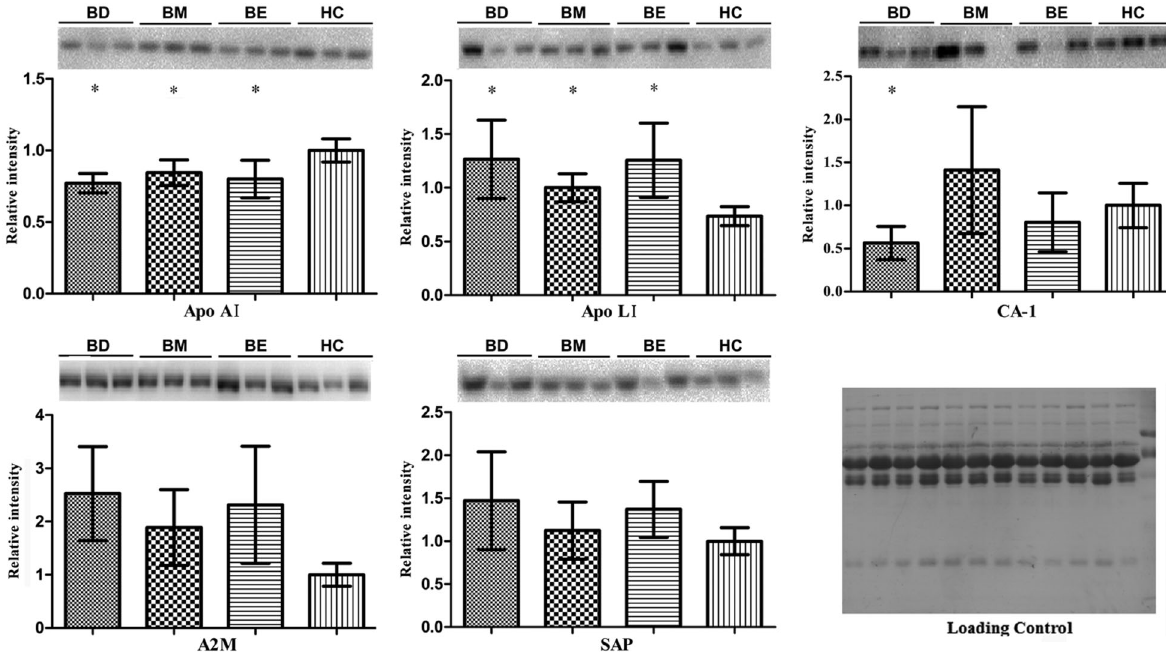
Figure 2. Western blotting of Apo A1, Apo L1, CA-1, A2M, and SAP. Proteins were analyzed in individual samples from healthy control subjects (HC, n=15) and bipolar disorder patients: BD: bipolar depression (n=15); BM: bipolar mania (n=15); BE: bipolar euthymia (n=10). All samples were analyzed in duplicate. Quantitative analysis of protein bands was performed using the Quantity One software (Bio-Rad, version 4.6.7). Data are reported as means ± SD. A representative subset of blots is presented for each protein. The Western blot results followed a normal distribution and were analyzed by one-way analysis of variance (ANOVA). Relative intensity of each protein was normalized to the total protein input of each lane (loading control), and fold-change was obtained and compared to a healthy control. *P o 0.05, compared to HC